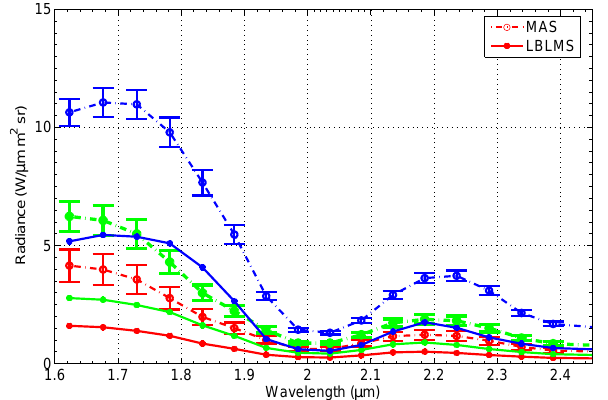
Fig. 15. Differences between LBLMS simulations and MAS obser- vation in cloudy conditions. Top and mid panel: relative radiance errors (LBLMS-MAS)/MAS; lower panel: absolute IR brightness temperature difference (LBLMS-MAS, K). The three colours rep- resent the three sections highlighted in Fig.